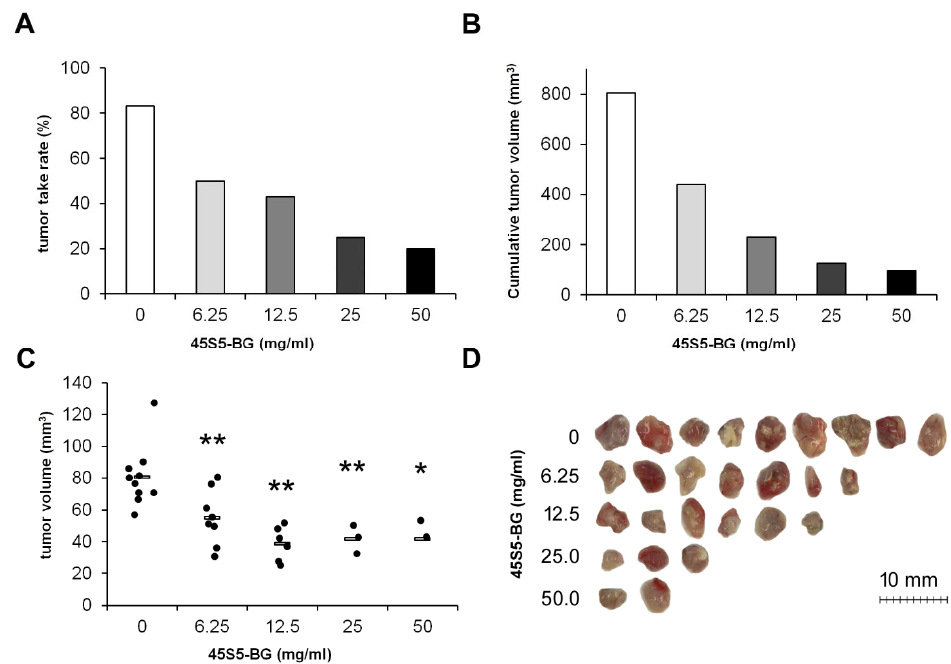
Figure 3. Concentration-dependent inhibition of tumor growth by 45S5-BG. GCTSC (1 × 10 6 per egg) were combined with 45S5-BG at the indicated concentrations and transplanted onto the CAM of fertilized chicken eggs ( n ≥ 20 per experimental group). After seven days, tumors that had formed were resected, and ( A ) the tumor take rate, ( B ) the cumulative tumor volumes, and ( C ) the individual tumor volumes were calculated. ( D ) Photographs of the resected tumors. (* p < 0.05, ** p < 0.01 compared to the control group without BG).